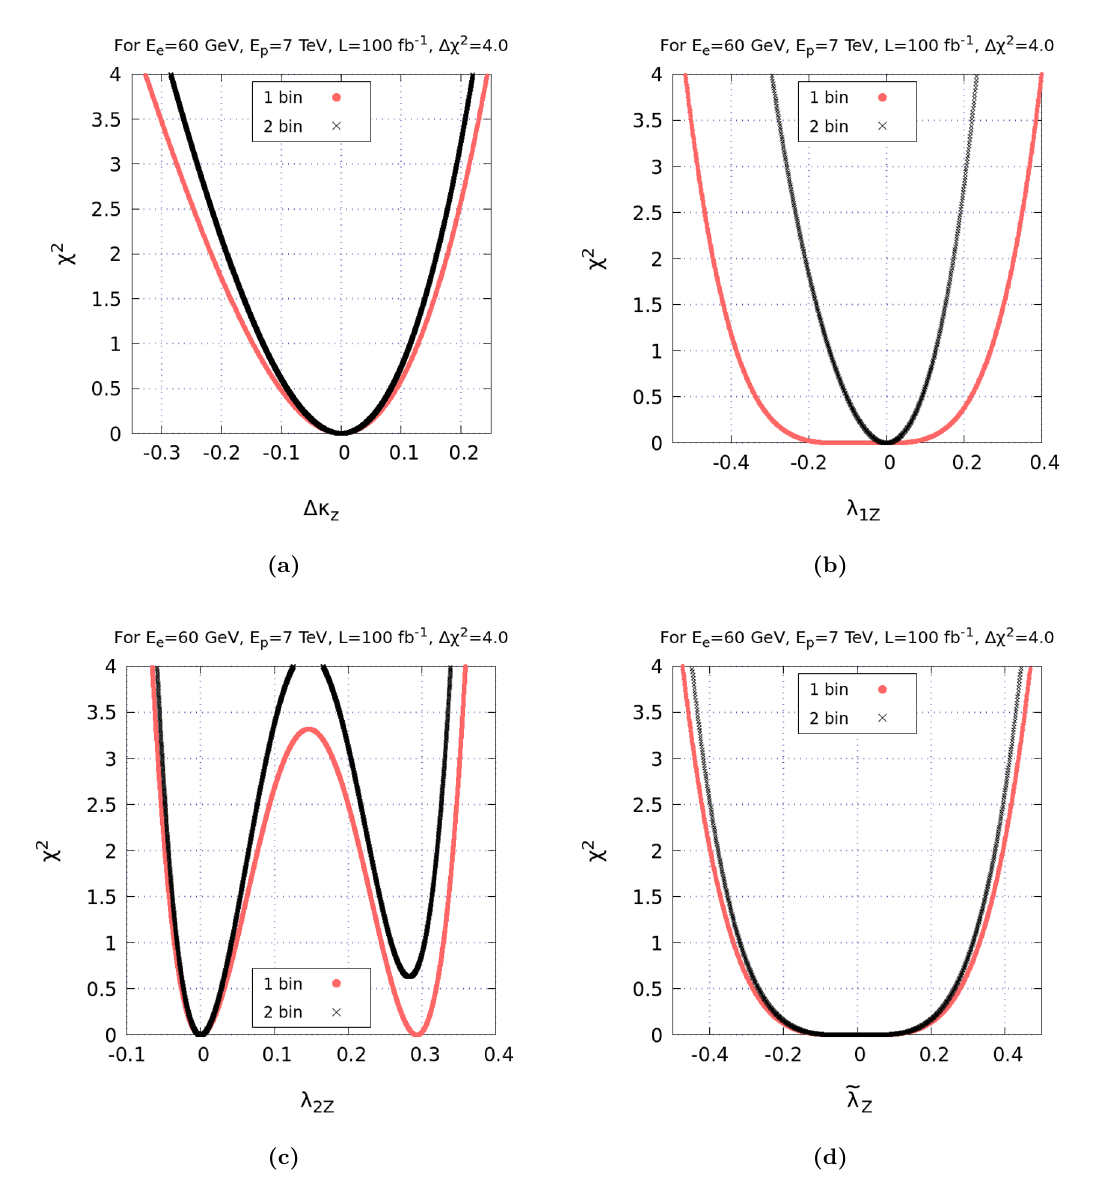
Figure 6 . χ 2 distribution for 1 bin (red curve) and 2 bins (black curve) of ∆ φ distribution in the NC process. In (a), we have defined ∆ κ Z = 1 − κ Z